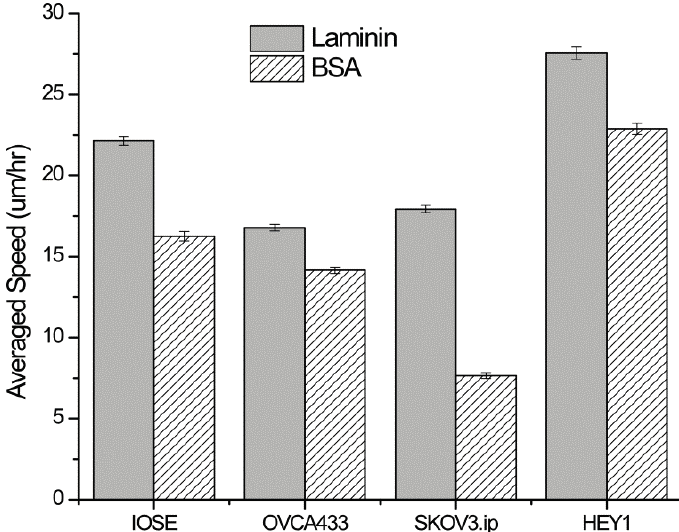
Figure 4. Average migration speed of the four cell lines on LN and BSA gradients made from the same parameters for the high slope design. All cells migrated with statistically faster speeds on the LN, demonstrating the importance of both ECM and contact cues. Error bars represent standard error. Data was analyzed from 40–100 cells in each